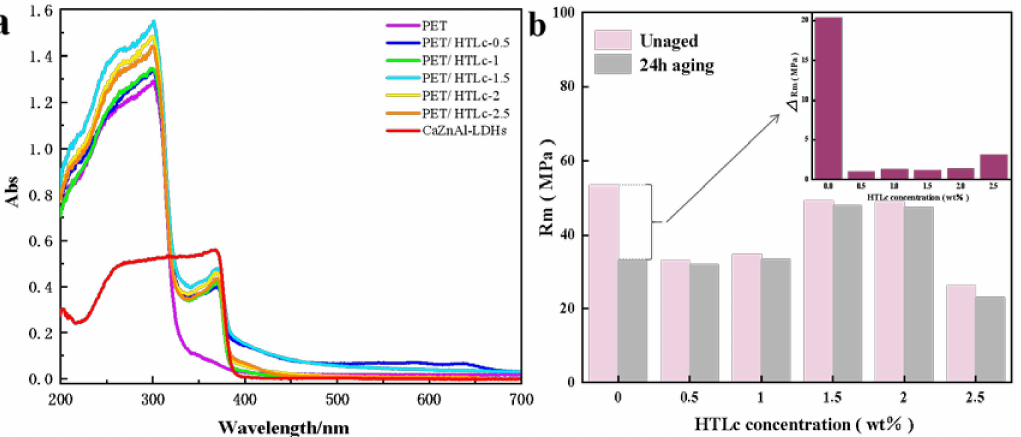
Figure 4. UV light resistance of PET/HTLc films: ( a ) UV absorption curves of PET/HTLc films. ( b ) Tensile strength of PET/HTLc films before and after 24 h UV aging.